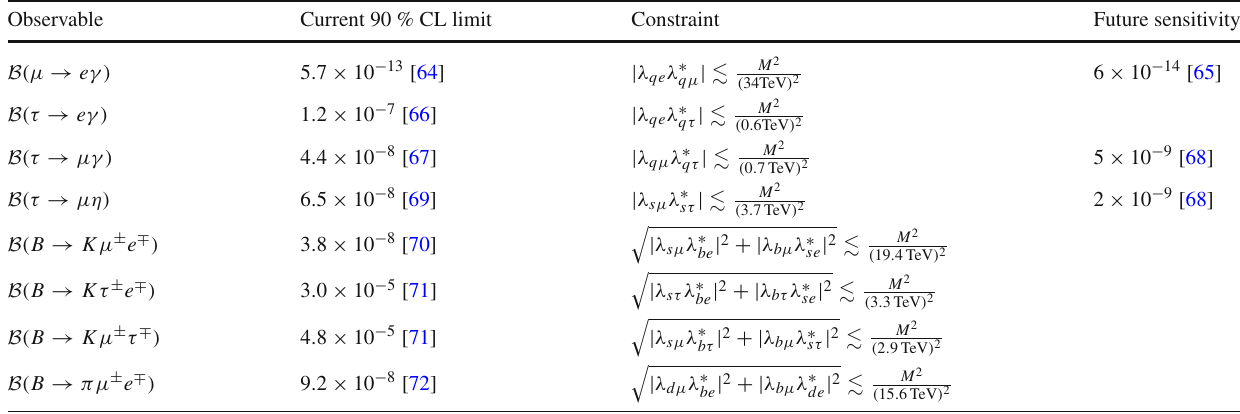
we ignored tuning between leading order diagrams in the amplitudes of (cid:16) → (cid:16) (cid:3) γ ,seee.g.,[73].Asin[74], d τ